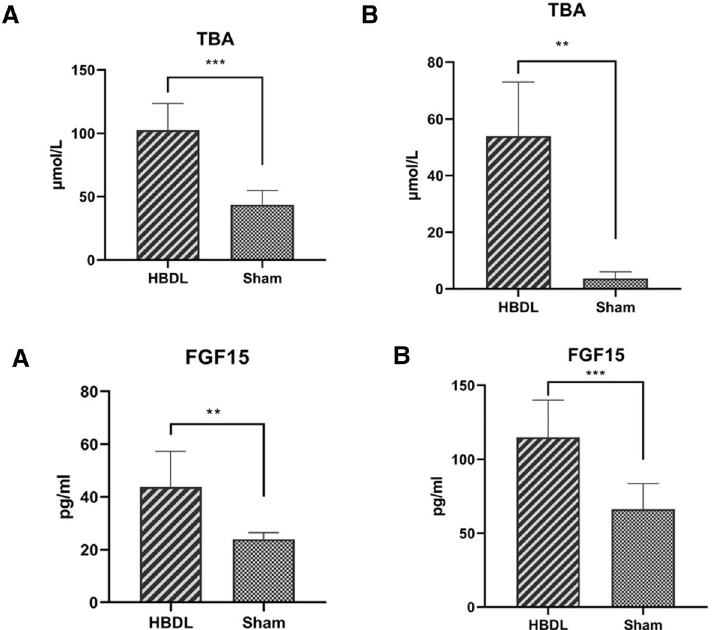
Figure 4. Serum levels of bile acid and FGF15 levels in the portal vein blood in HBDL mice at different time points, * p < 0.05 versus the sham group. The first day after surgery ( A ); the first week after surgery ( B